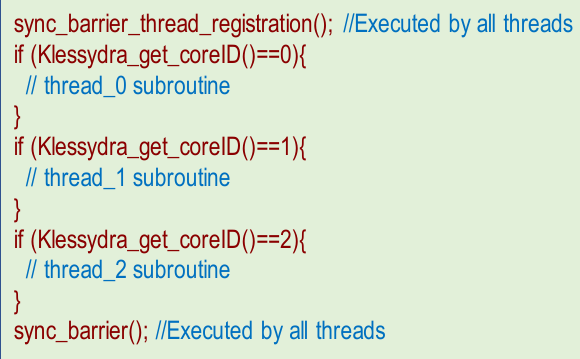
Figure 4. Code for multi-threaded execution on Klessydra-T1. Figure 5 gives a representation of the memory map assumed by the Klessydra T1